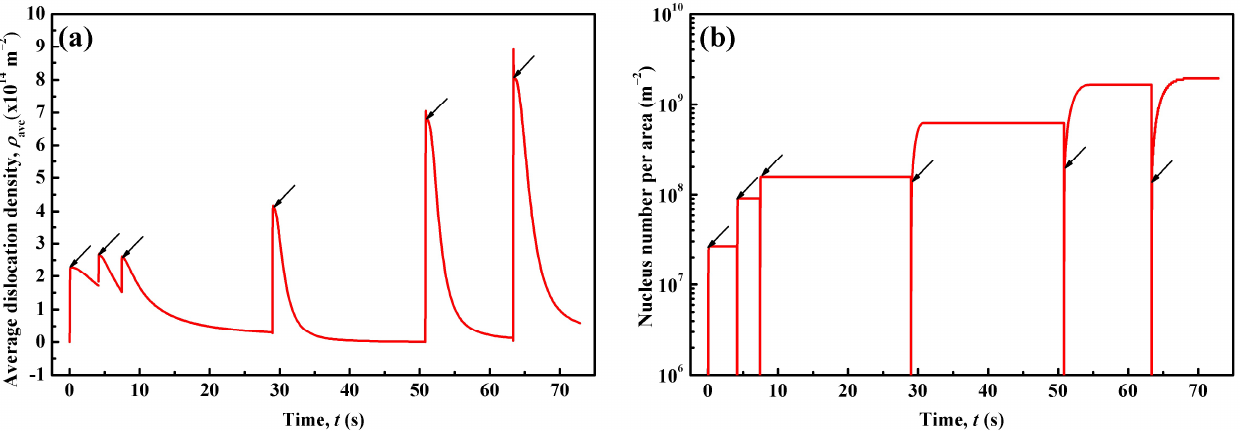
Figure 3. CA-simulated ( a ) average dislocation density and ( b ) recrystallized nucleus density varying with time. Arrows in the curves indicate the end of each pass.